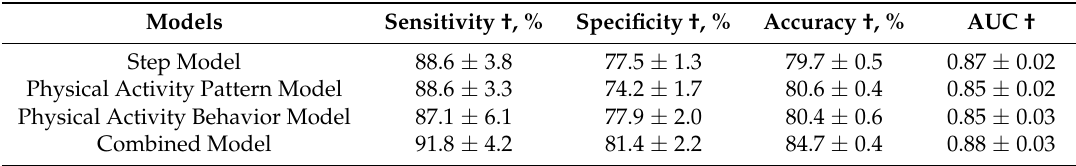
Table 4. The performance of models to separate the pre-frail group from the rest of the groups (non-frail and